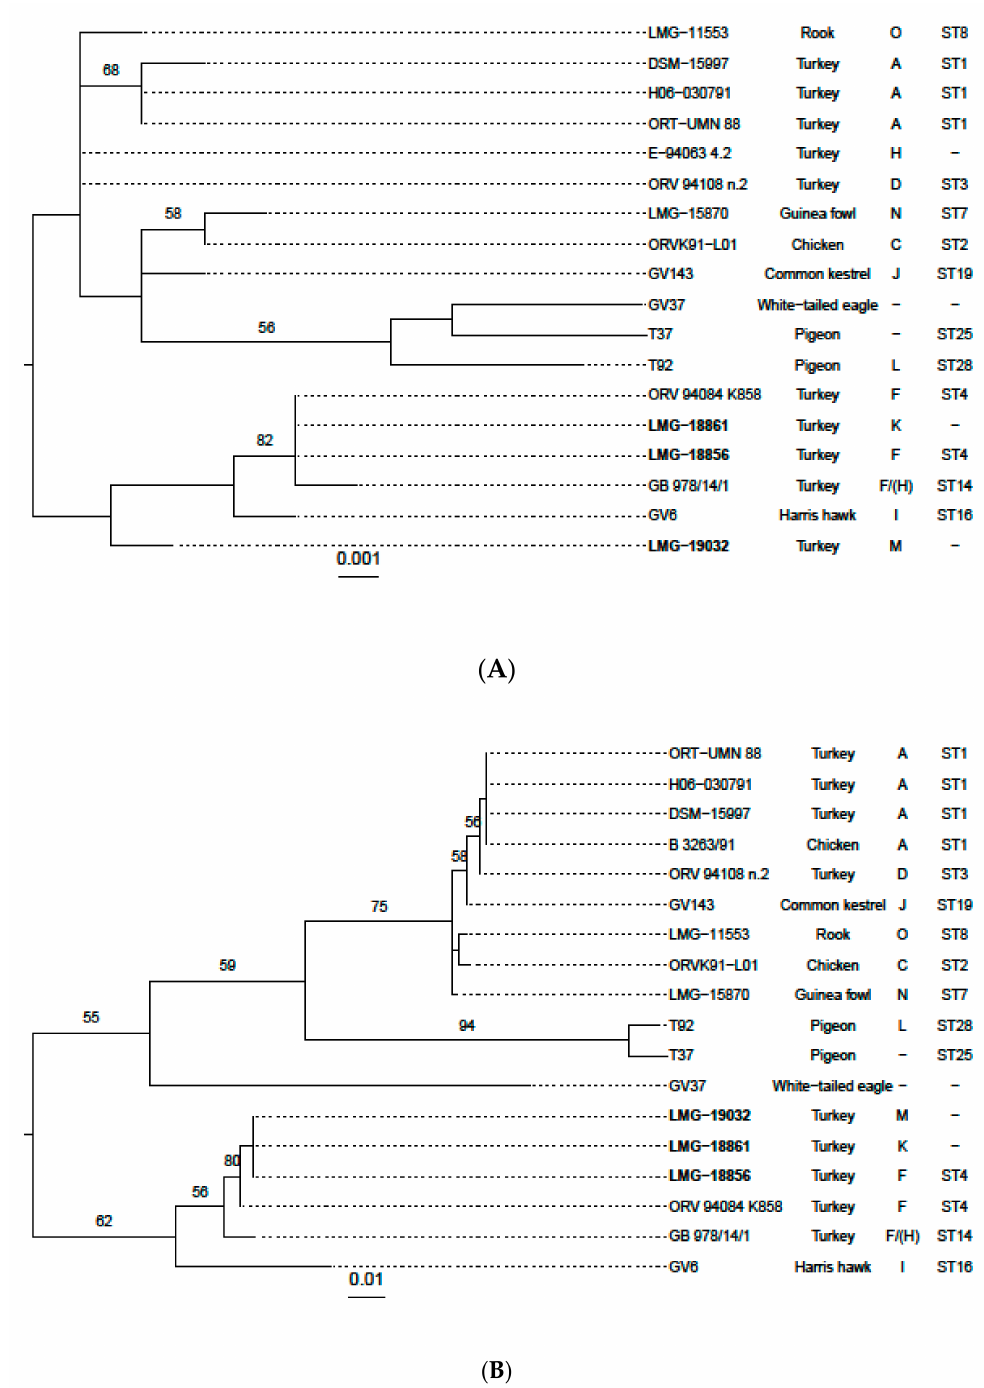
Figure 5. Maximum likelihood tree constructed from 16S-RNA ( A ) and rpoB ( B ) sequences using RAxML with a general time-reversible model with gamma-distributed rate variation and 1000 bootstraps. Bootstrap values greater than 50 percent are shown on branches. Sequences from Cand. O. hominis ( O. sp. OH-22767 & OH-2280 ) were used as an out-group for rooting. The text columns give host, serotype and sequence type (ST) according to PubMLST. The newly sequenced strains are indicated in boldface. For strains with identical sequences only one was included for calculations (16S-RNA: ORV 94,084 K858, LMG-18861, LMG-18856; ORT-UMN88, H06 − 030791; E − 94063 4.2, ORV 94,108 n.2, rpoB: ORT − UMN 88, H06 − 030791, DSM − 15997, B 3263/91; LMG − 18856, LMG − 18861, LMG −